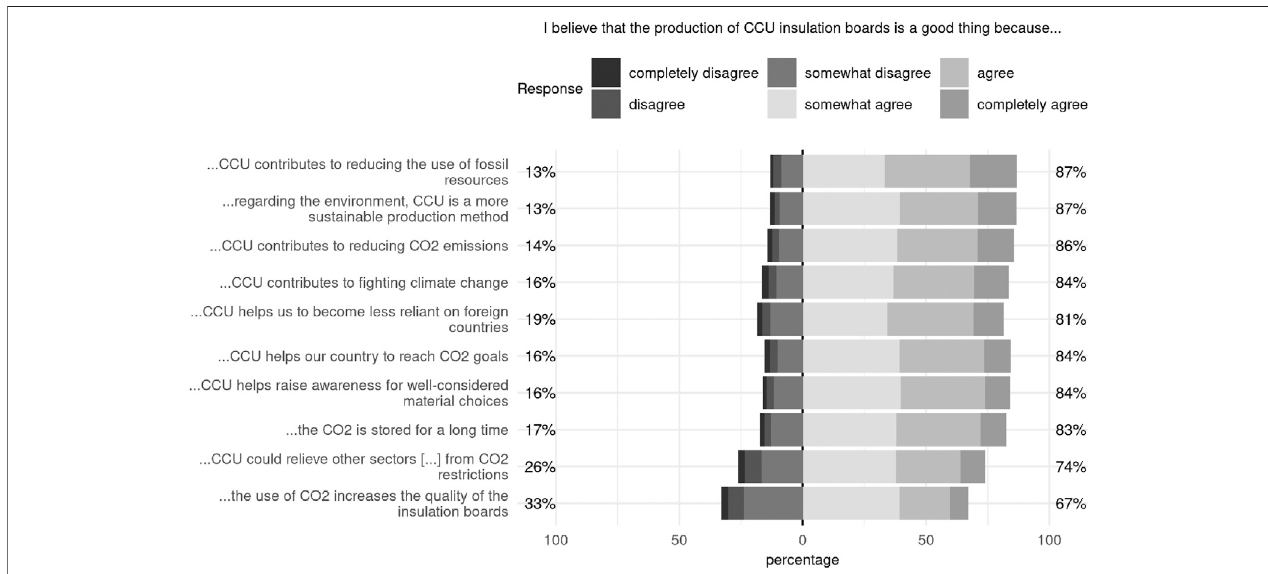
FIGURE 3 | A visual representation of the shares of the given answers to the statements on the bene fi ts of CCU insulation boards ( N (cid:1)